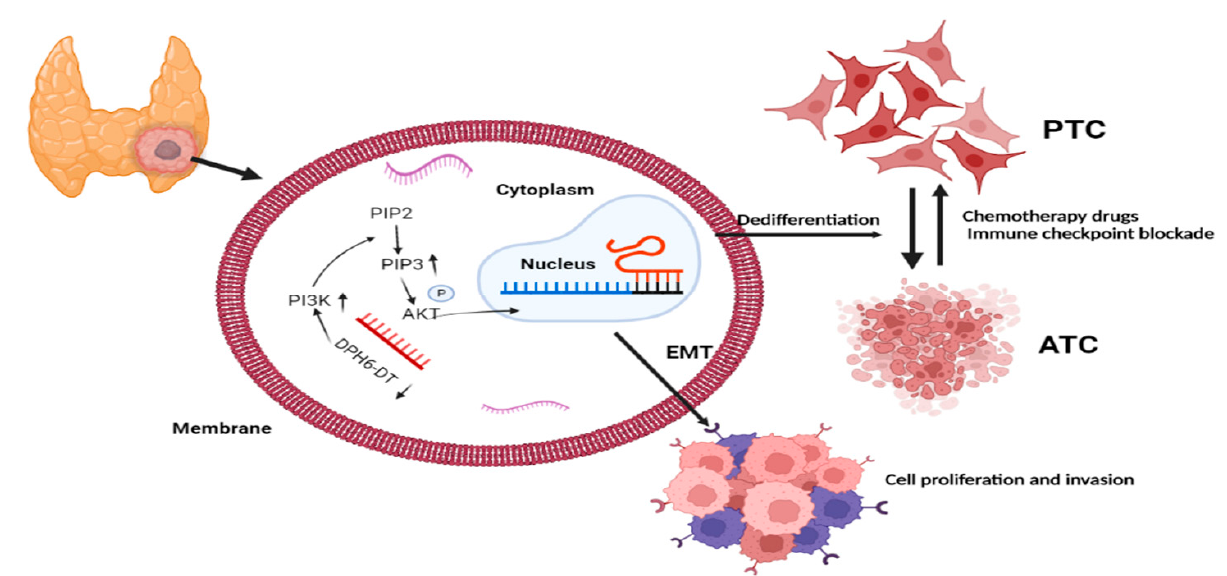
Figure 9. Brief summary for the molecular mechanism of DR-lncRNAs. EMT: epithelial-mesenchymal transition. ATC: anaplastic thyroid cancer. PTC: papillary thyroid cancer. Biorender, available online: https://app.biorender.com (accessed on 2 November 2021).